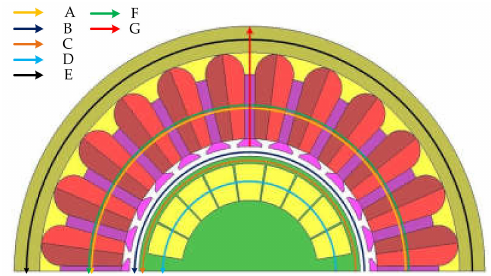
Figure 3. Study position of the